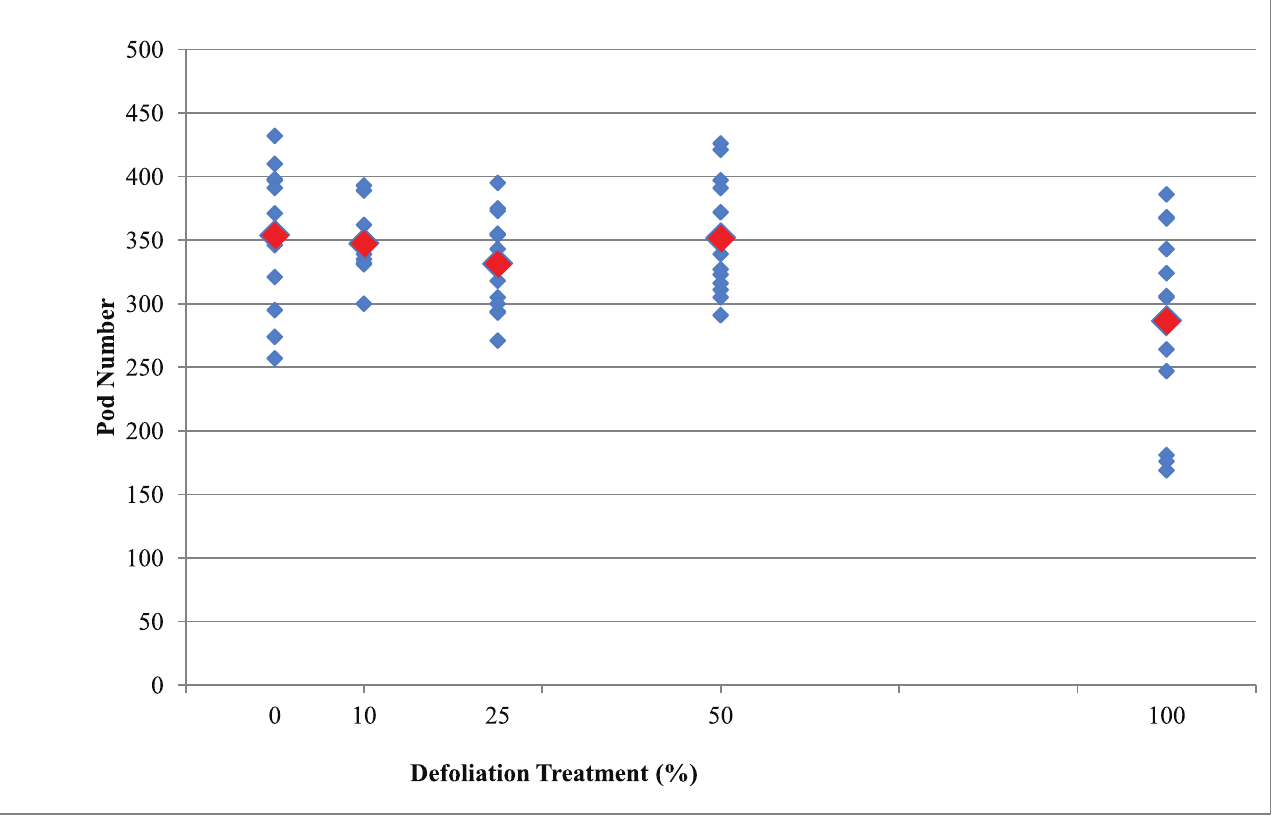
Fig 5. The number of pods produced per individual wild soybean plant after different defoliation treatments. The blue diamonds are the total number of pods per plant and the red diamonds are the mean number of pods across all plants within each defoliation treatment.